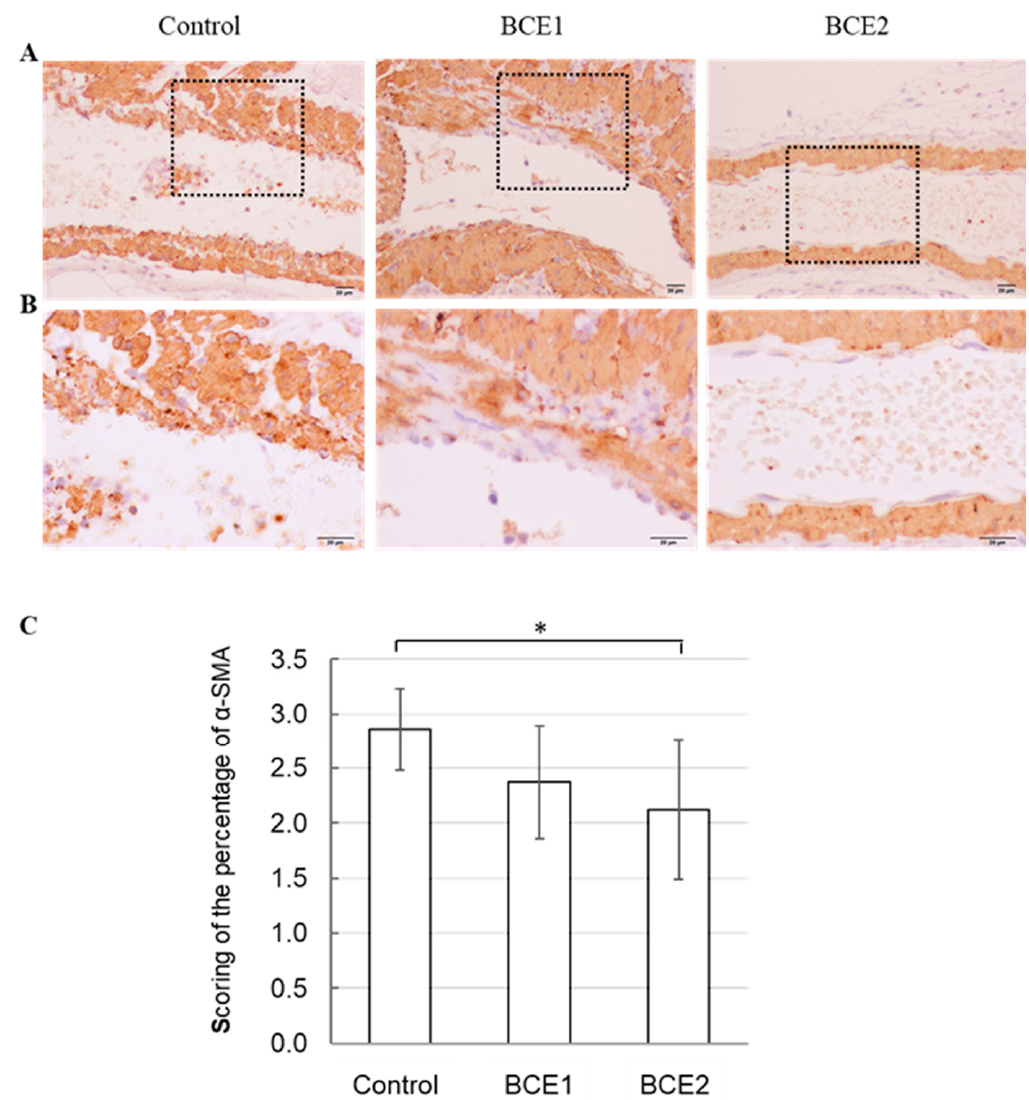
Figure 3. Immunohistochemical staining of α -SMA in the Control (high-fat diet without BCE), BCE1 (high-fat diet supplemented with 1% BCE powder), and BCE2 (high-fat diet supplemented with 3% BCE powder) groups. ( A ) α -SMA expression at a lower magnification (200 × , scale bar = 20 µ m). ( B ) A higher magnification of the boxed areas shown in panel A (400 × , scale bar = 20 µ m). ( C ) Scoring of the percentage of α -SMA-positive cells in the tunica intima of the specimens from each group. Data are expressed as the mean score ± standard error. * p < 0.05.